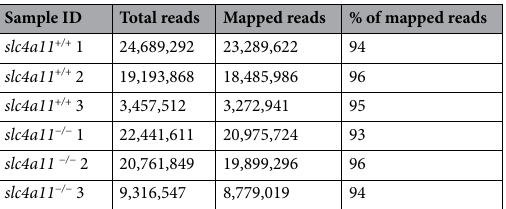
Table 1. Sequencing run mapping statistics. Percentage of trimmed and filtered reads successfully mapped to the genome, from total reads sequenced for each